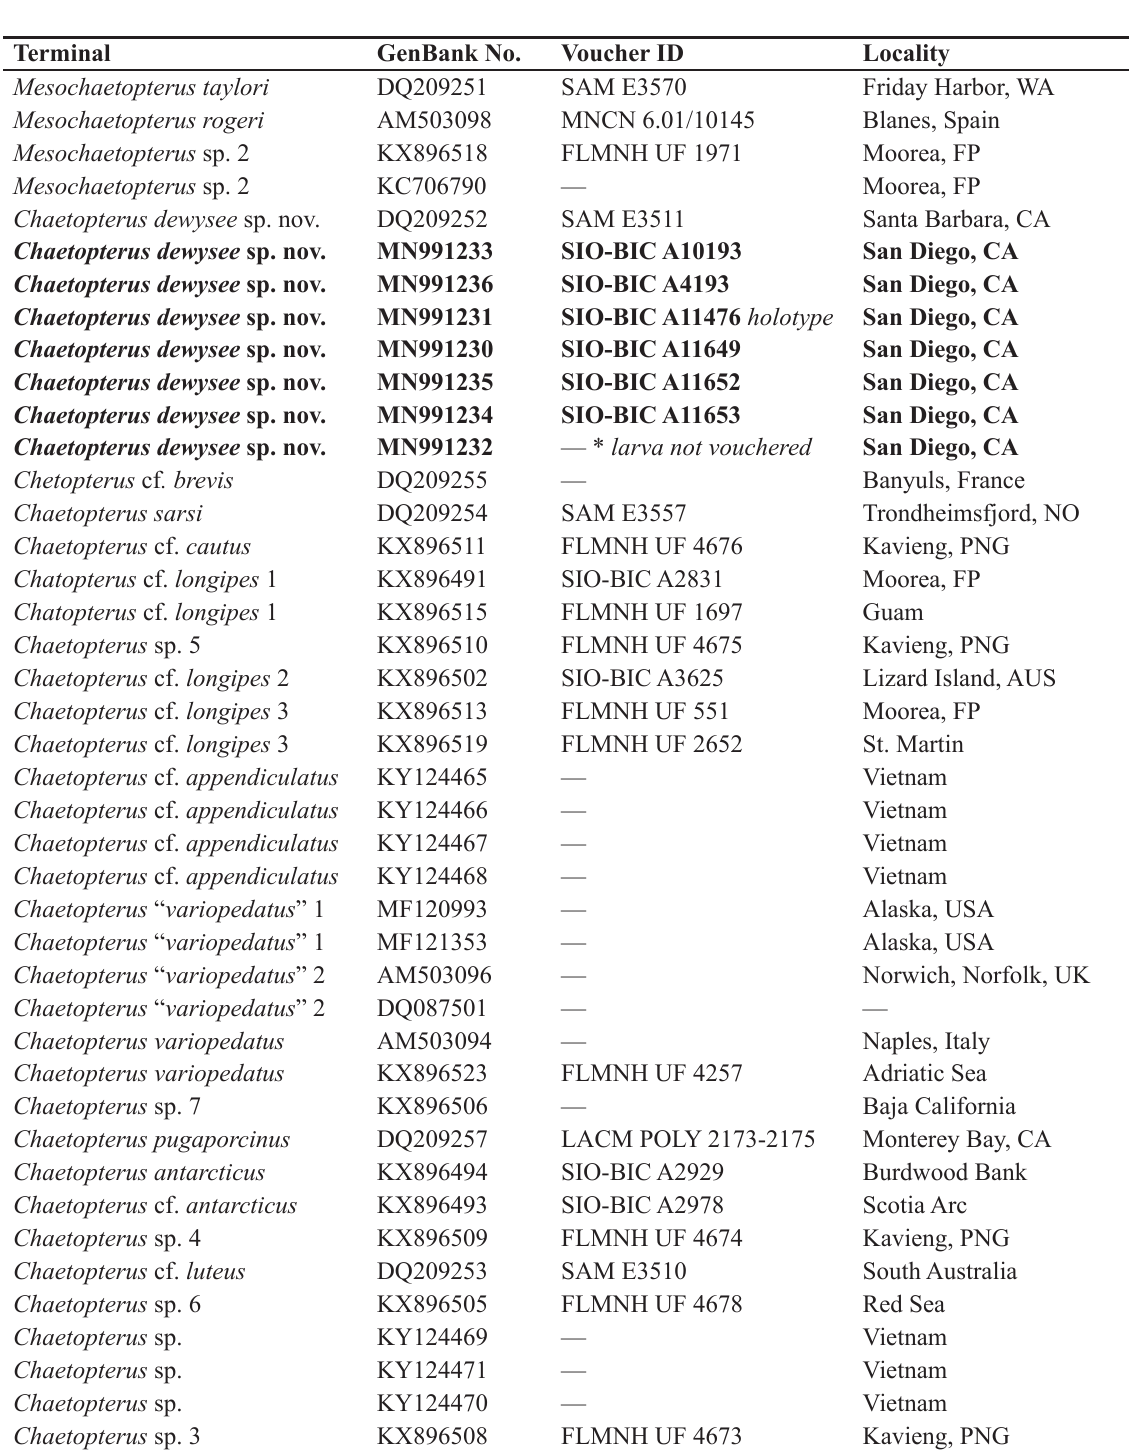
Table 1. List of sequenced Chaetopterus dewysee sp. nov. specimens and analyzed COI sequences with GenBank repository, voucher and locality information. Species names are listed as they are shown in Fig. 5. New sequences are in bold. Voucher holding institution abbreviations are: SIO-BIC = Scripps Institution of Oceanography Benthic Invertebrate Collection; FLMNH = Florida Museum of Natural History; SAM = South Australian Museum; LACM = Natural History Museum of Los Angeles County; MNCN = Museo Nacional de Ciencias